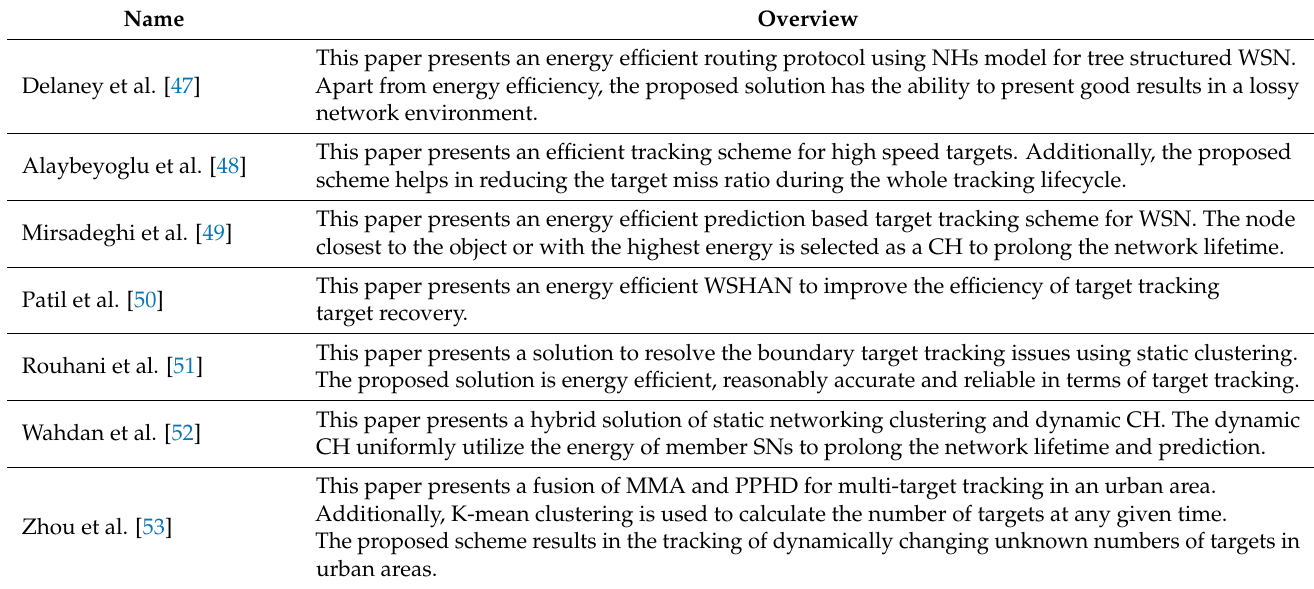
Table 4. Key ideas of selected